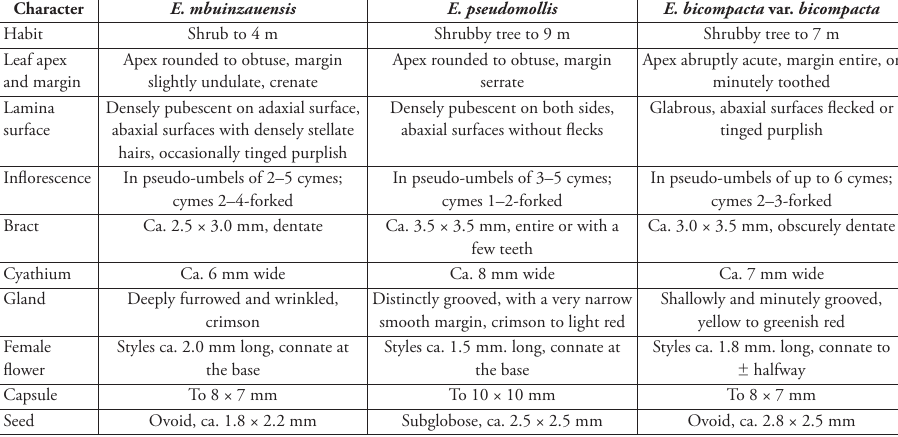
Table 1. Characters distinguishing Euphorbia mbuinzauensis from E. pseudomollis and E. bicompacta var. bicompacta